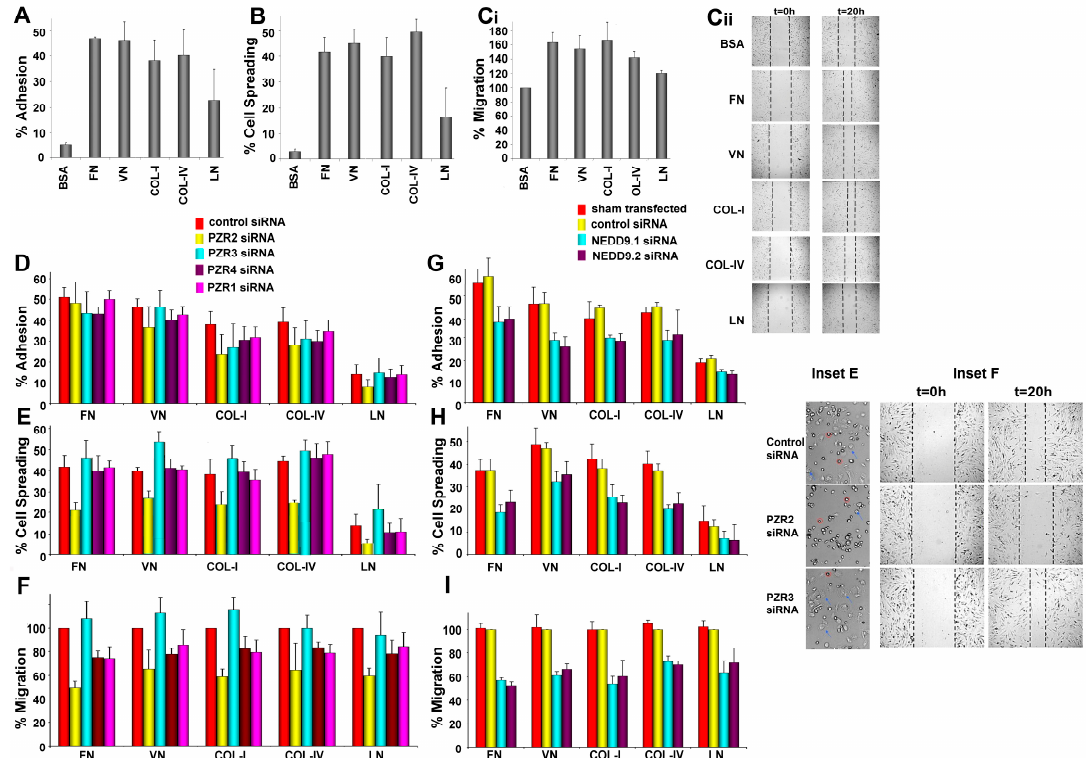
Figure 2. Effects of PZR on hBM MSCs in regulating adhesion to and spreading and migration on ECM molecules. ( A ) BCECF ‐ labeled hBM MSC adhesion to BSA, FN, VN, COL ‐ I, COL ‐ IV, and